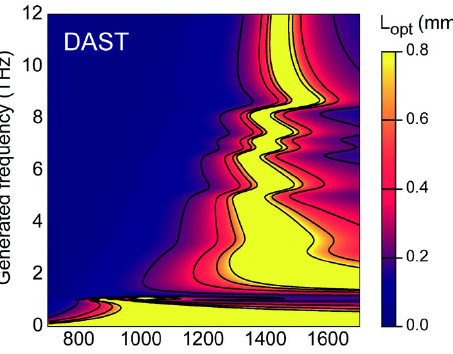
Figure 10. Optimum crystal length l opt ( ν , λ ) for the generation of THz waves as a function of the pump optical wavelength and the frequency of the generated THz wave for DAST, for both pump and THz waves polarized along the polar axis. Used with permission from the Royal Society of Chemistry, from [195]; permission conveyed through Copyright Clearance Center, Inc. Table 11. Main optical-THz characteristics of